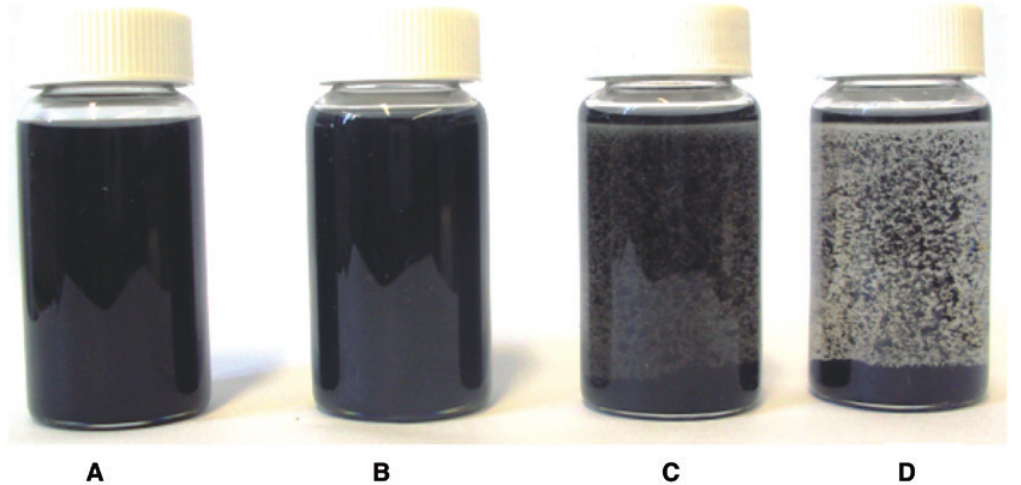
Figure 1: Photographs of various CNT dispersion in dilute epoxy solution (xylene-butanol (1:1) mixture) when the mixture was allowed to settle for 6 h. (A) CNT-ODA; (B) CNT-OH; (C) CNT-COOH; (D)